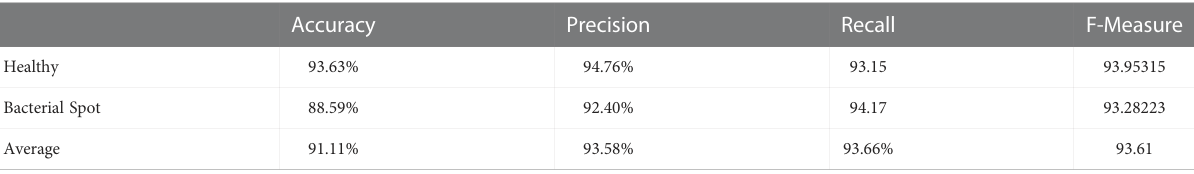
TABLE 8 Detail Performance by class for pepper disease